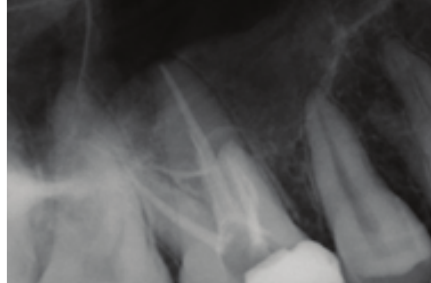
Figure 2: Postobturation radiograph showing all 3MB canals exit- ing as single